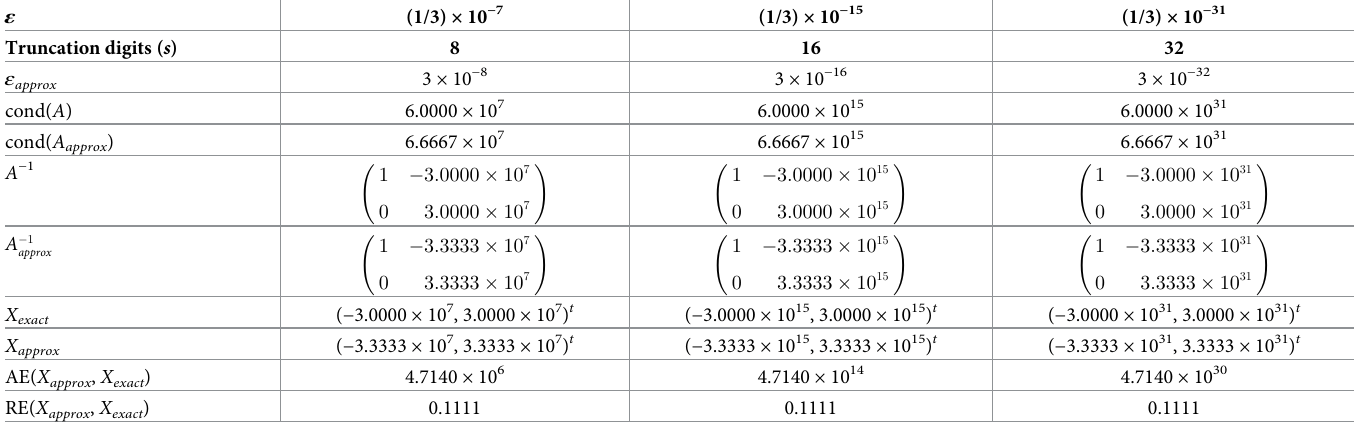
Table 3. Numeric results by truncating ε to too few